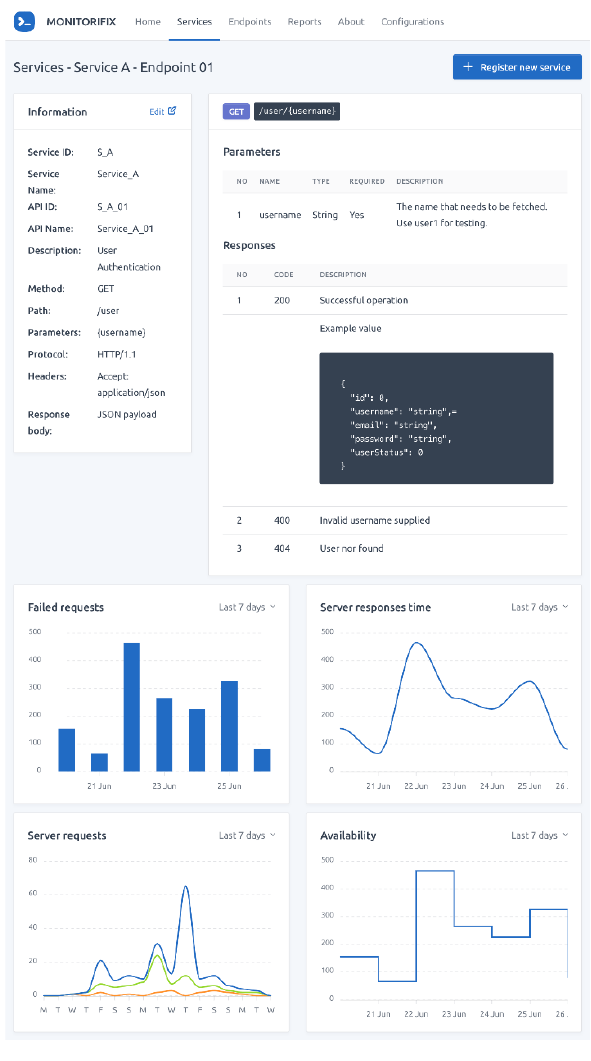
Figure 12. The four parameters status of one